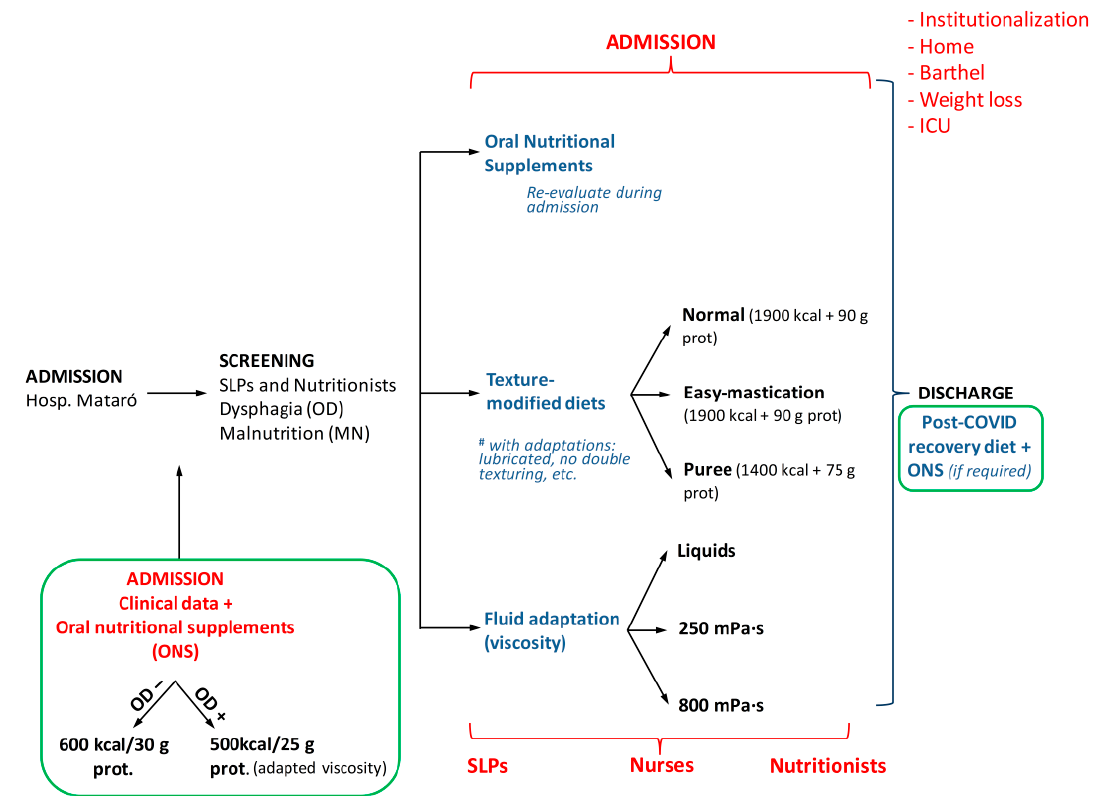
Figure 1. Management of patients with COVID-19 disease, oropharyngeal dysphagia and risk of malnutrition. In green, the new management directives introduced in the second and third waves.